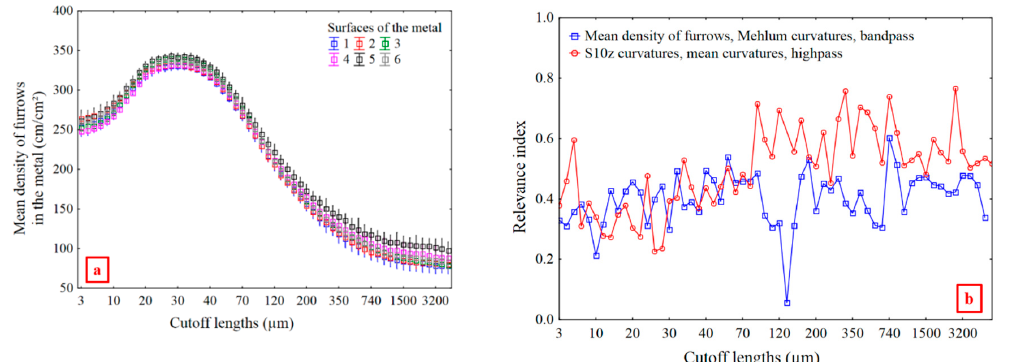
Figure 15. Mean density of furrows vs multiscale cutoff lengths for metal, Mehlum curvatures, and a band pass filtering ( a ). Relevance index versus cutoff lengths for the mean density of furrows for Mehlum curvatures and a band pass (blue), and S10z curvatures for mean curvatures and a high pass (red) ( b ).